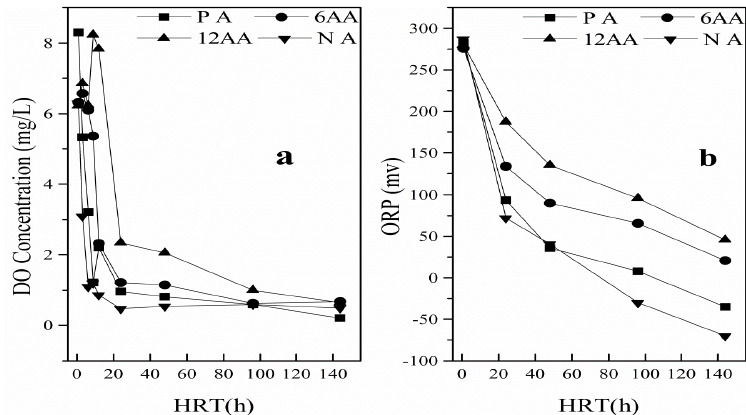
Figure 2. The changes in DO ( a ) and ORP ( b ) in HSSF-CWs with different aeration modes with increasing HRT (PA: Pre-aeration at 24 h before the input of influent water; 6AA: Aeration at 6 h after the input of influent water; 12AA: Aeration at 12 h after the input of influent water; NA: Non-aeration). HRT: hydraulic retention time.